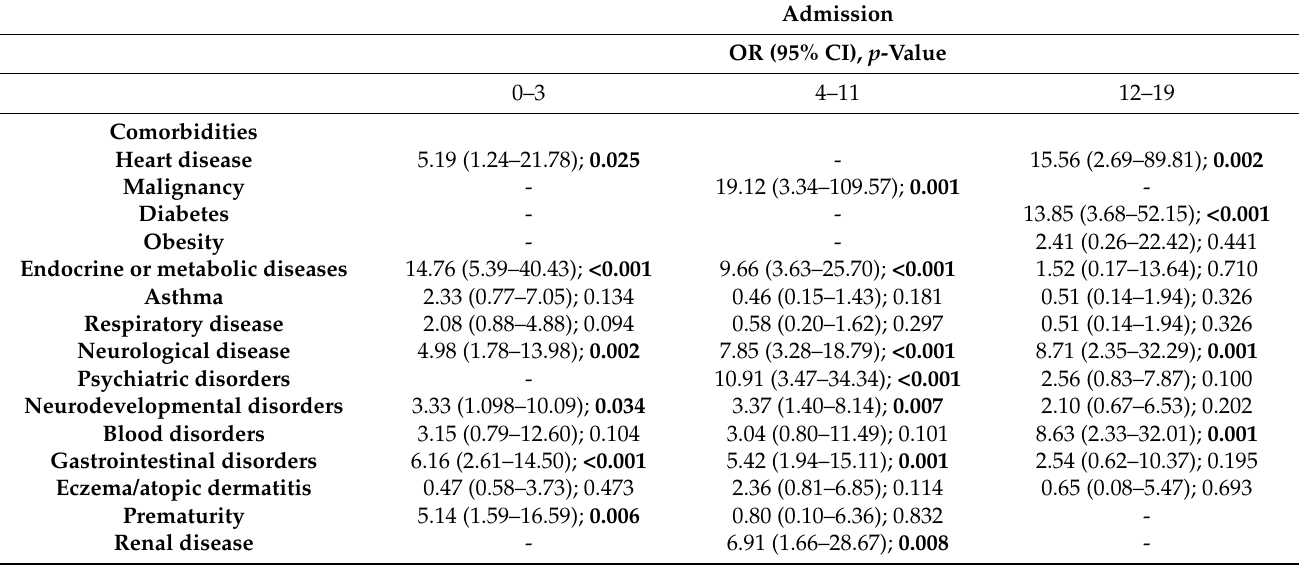
Table 4. Association between different variables and hospital admission for influenza by age